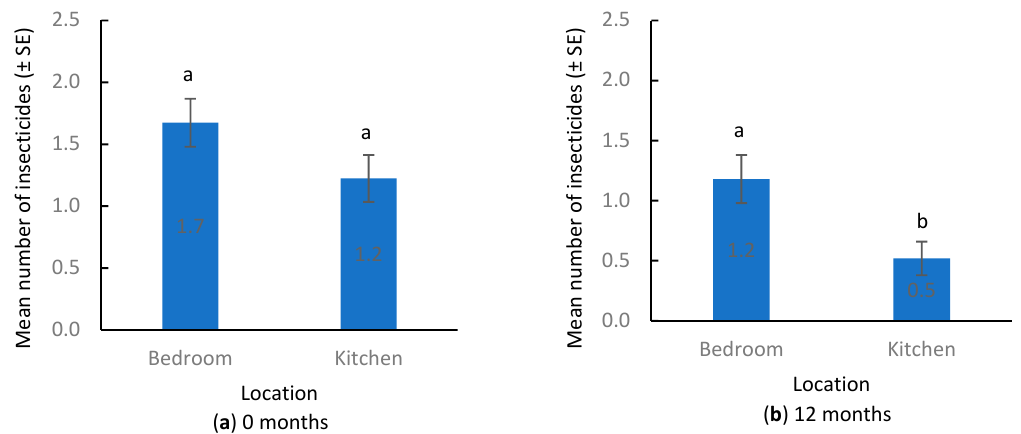
Figure 4. Number of insecticides detected by location. ( a ) 0 months, ( b ) 12 months. Different lowercase letters above the bars indicate significant differences between room type (Wilcoxon signed-rank test, p < 0.05).